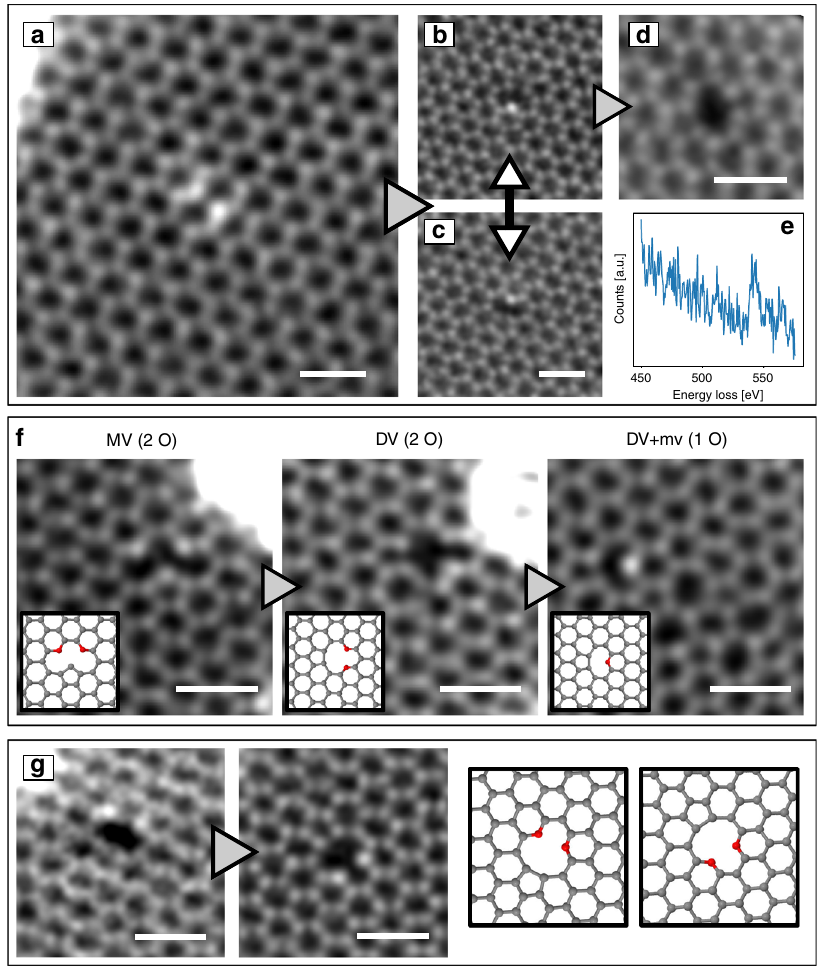
Fig. 4 In situ oxygen reduction and dynamics in GO. a STEM image of the oxygen pair con fi guration. b , c One oxygen is released after several scans, creating a vacancy beside the oxygen atom. The oxygen atom jumps frequently to the opposite equivalent site. d Second oxygen is knocked out after several scans creating a divacancy. e EEL spectrum of a double-O con fi guration, which converted into single-O during spectrum acquisition (total dose: ca. 2 × 10 10 e − Å − 1 ). f Reduction process of oxygen. g Rotation of the 5-8-5 DV with two oxygen atoms. Scale bar is 0.5